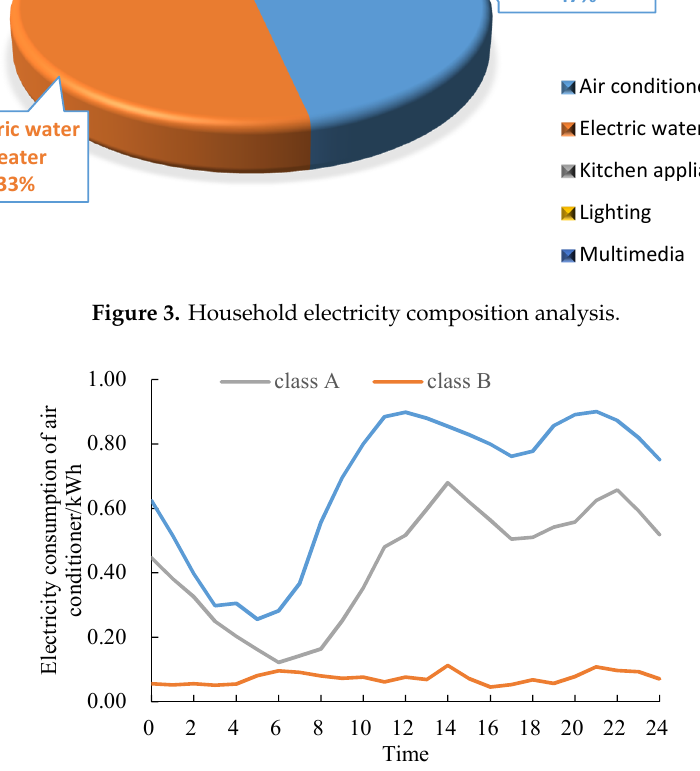
Table 1. Daily load rate.